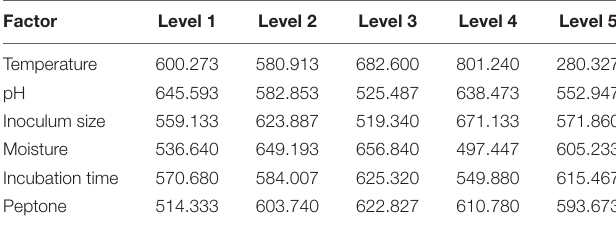
TABLE 4 | Response of each factor on the production of extracellular xylanase by P. purpurogenum